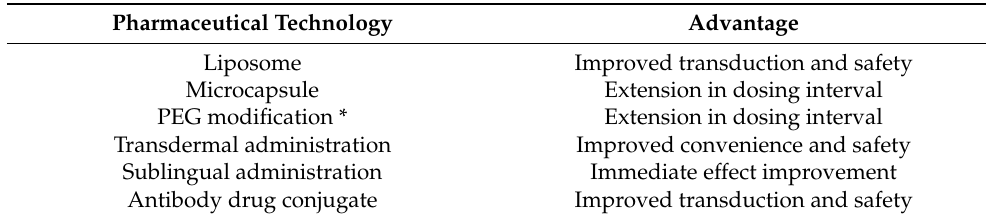
Table 1. Drug-delivery-system strategies.